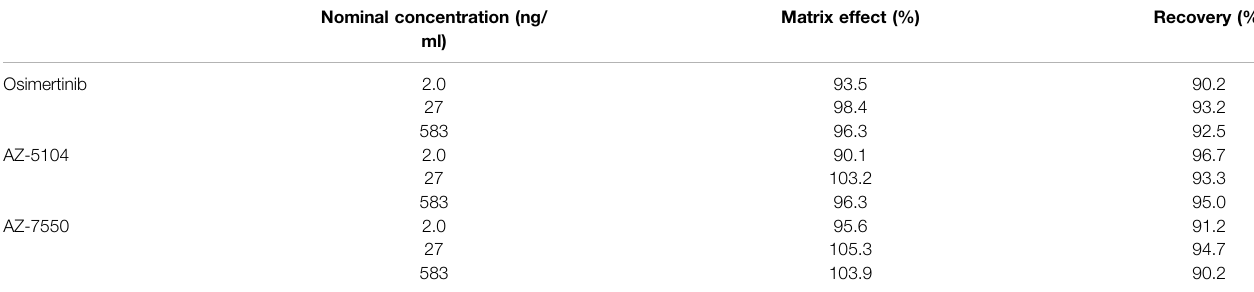
TABLE 3 | Matrix effect and recovery of osimertinib, AZ-5104, and AZ-7550 in SD rat plasma ( n =